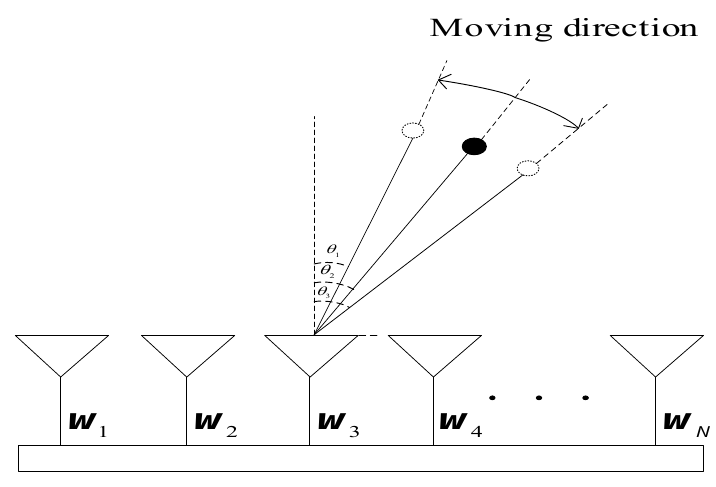
Figure 1. Moving target model based on uniform linear array.